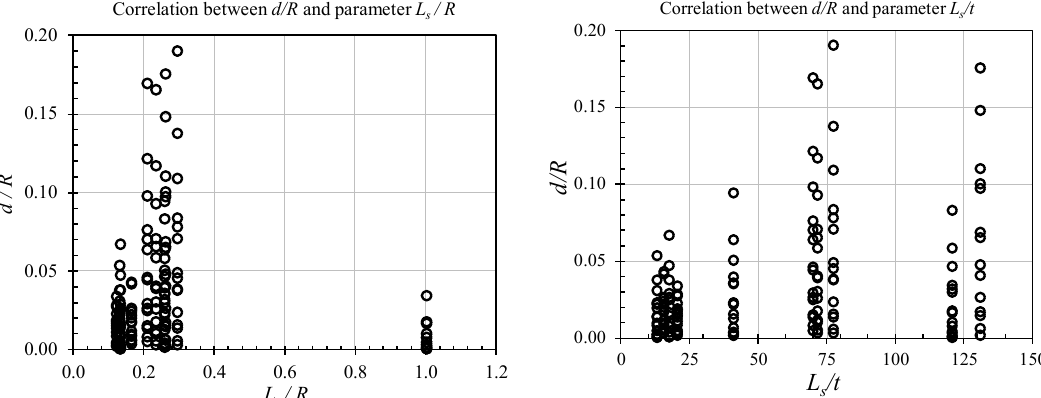
Figure 16. Tendencies of d/R with non-dimensional basic parameters L s /R and L s /t for the ring-stiffened cylinder.